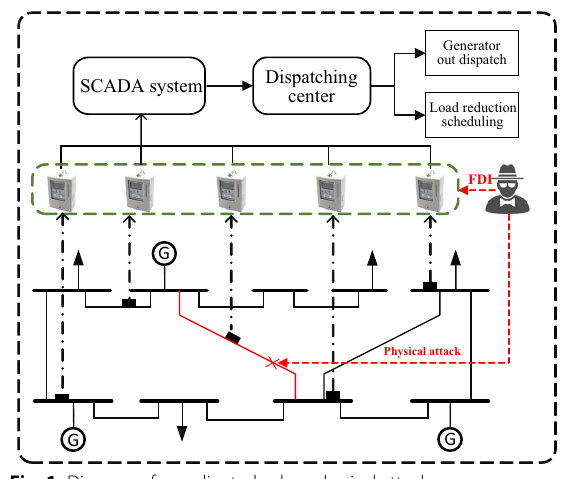
Fig. 1 Diagram of coordinated cyber-physical